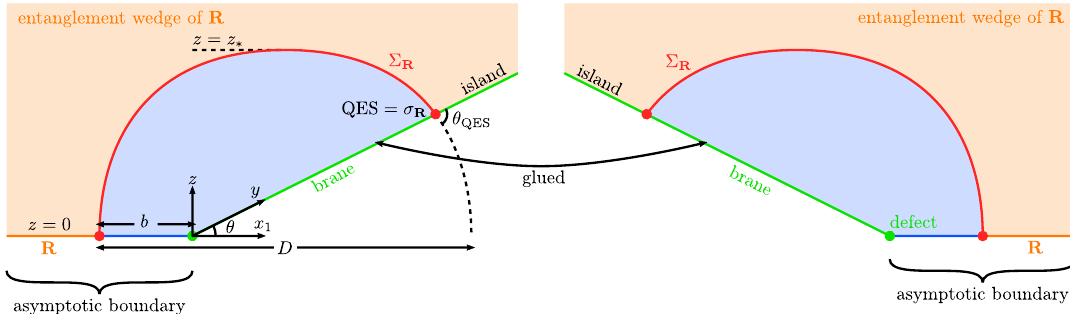
Figure 20. The bulk dual to a d -dimensional Minkowski CFT with a defect (green dot) along a line x 1 = 0 . The CFT lives on the asymptotic boundary of a Poincaré AdS d +1 spacetime with a brane (green line) running through it. We consider the entanglement entropy of the complement R = ( −∞ , − b ] ∪ [ b, ∞ ) of a belt geometry in the CFT. As considered in section 5.1, one candidate RT surface Σ R , shown in red, intersects the brane at a QES σ R , forming an island on the brane belonging to the entanglement wedge of R . Various quantities defined in section 5.1 are marked in this figure.